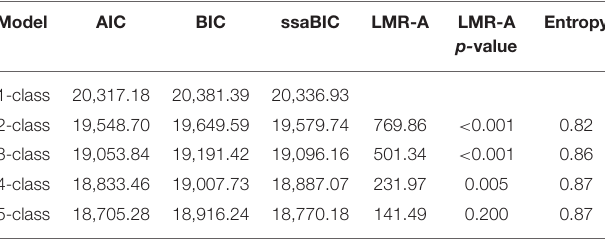
TABLE 3 | Fit of competing latent profile models.